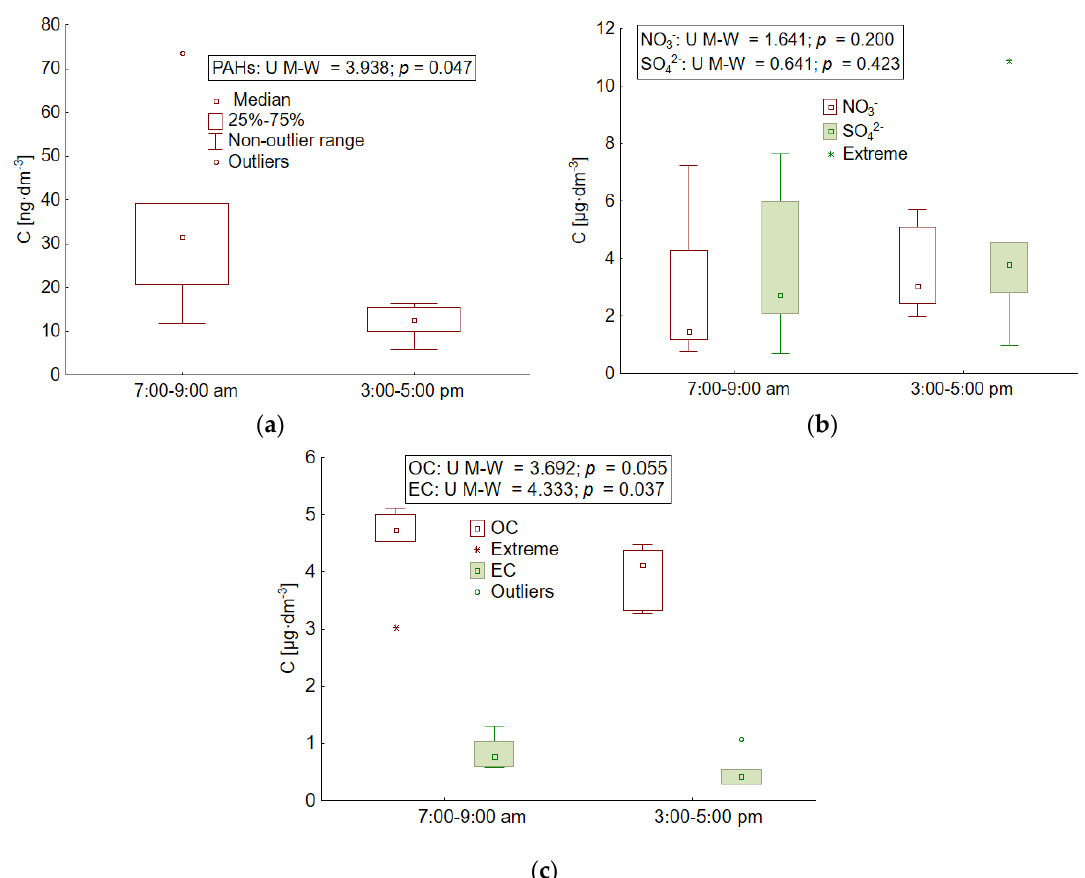
Figure 4. Statistical characteristics of the concentration of: ( a ) PAHs, ( b ) nitrate and sulphate ions, ( c ) and OC and EC in the morning and afternoon rush hours in the atmosphere over Gdynia during the school period in 2015.